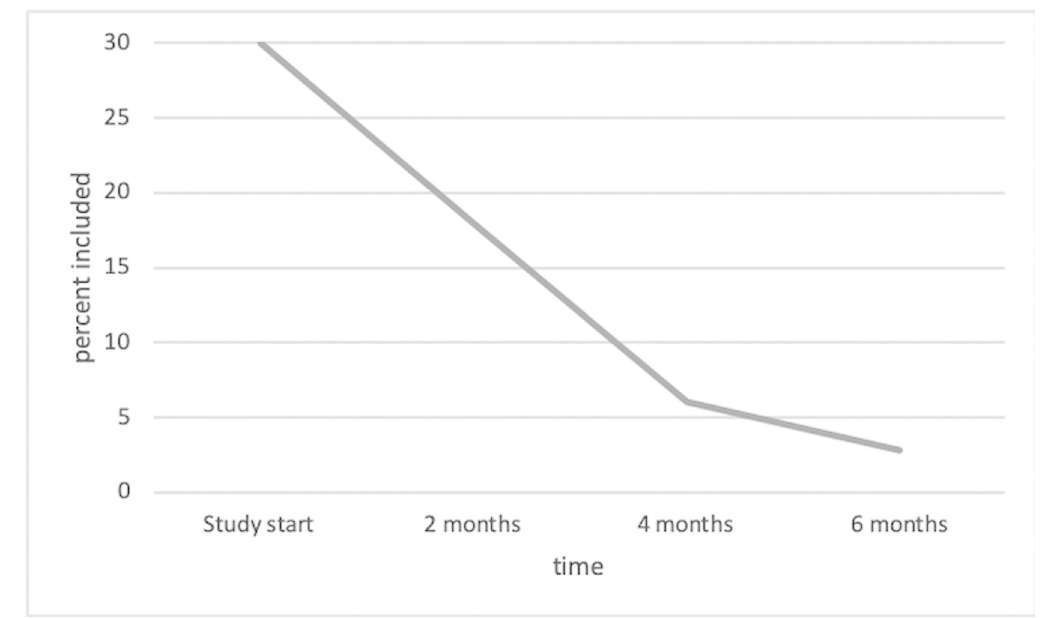
Fig 1. Recruitment rate of patients attending the ED during the study